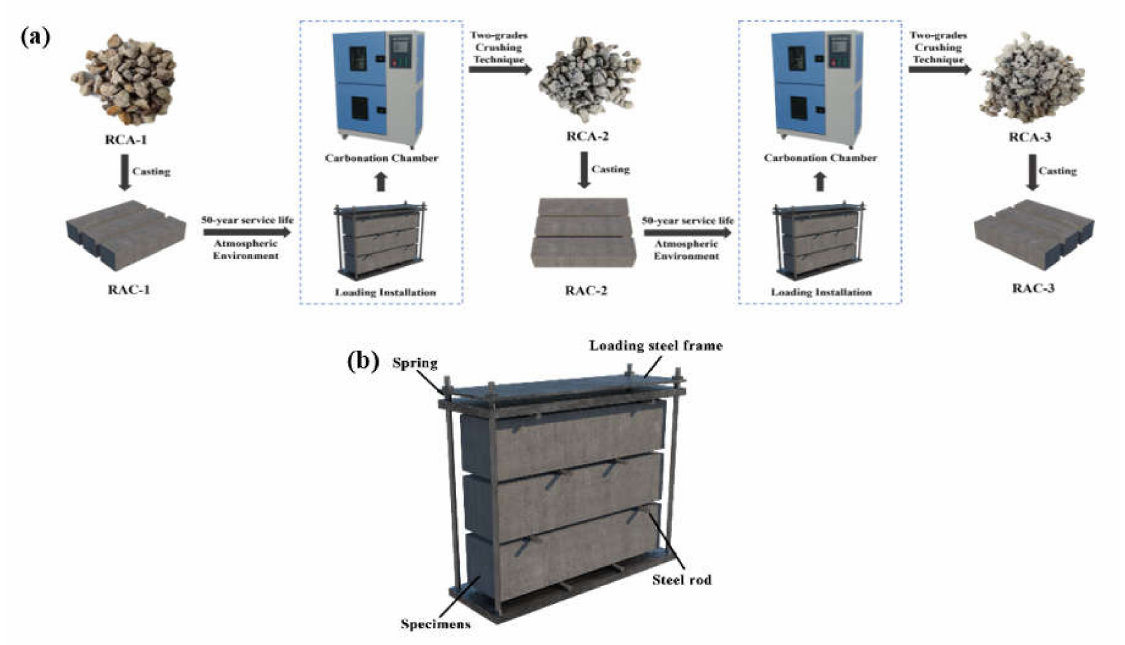
Figure 1. ( a ) Schematic for preparation process of recycled concrete aggregate (RCA) and repeatedly recycled aggregate concrete (RRAC) and ( b ) loading device of RRAC.